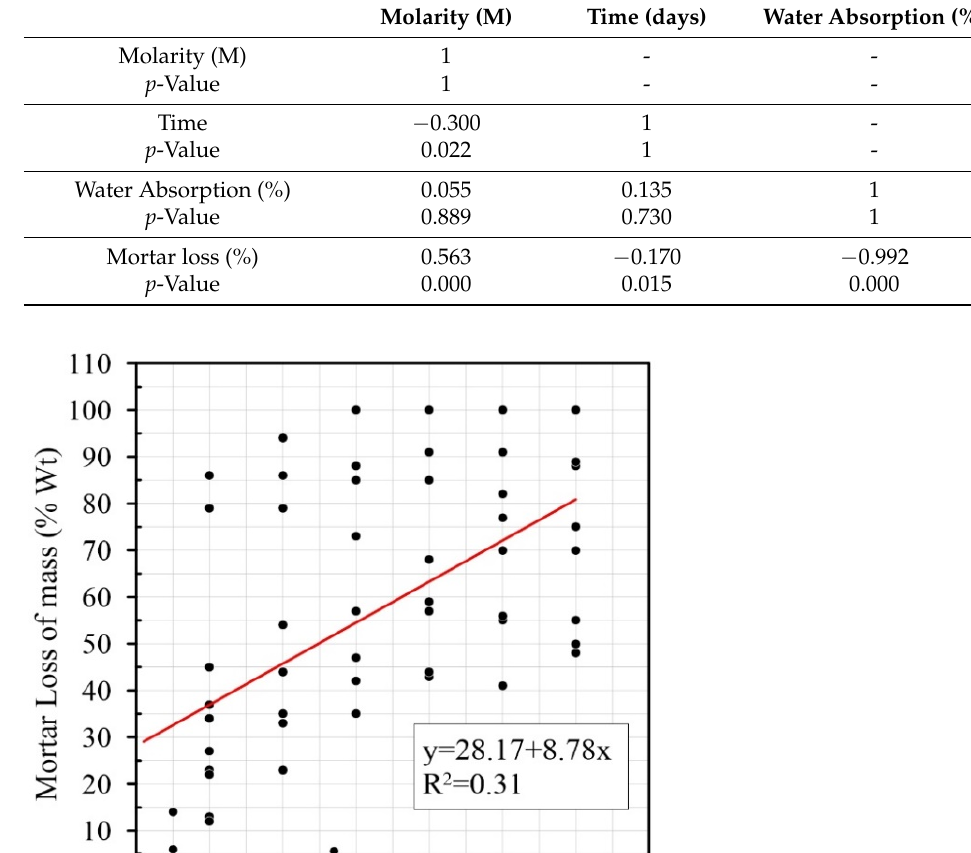
2 SO 4 and mortar loss of mass (% Wt)